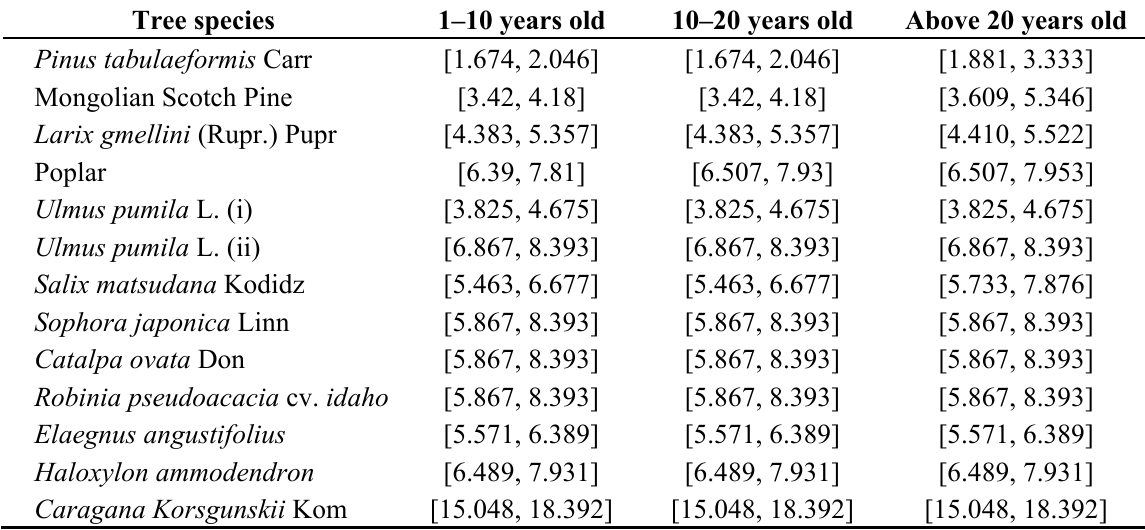
Table 2. Carbon sink capacities per unit area of each tree species for different stand ages. Tree